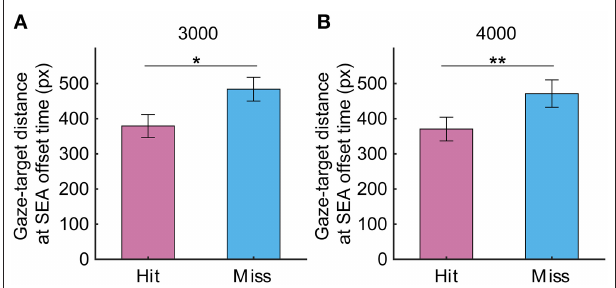
FIGURE 6 | The gaze target distance at target speeds of (A) 3,000 and (B) 4,000 pixels/s in Experiment 1. Pink and light blue bars show Hit and Miss, respectively. Error bars are SEM. * p < 0.05, ** p <